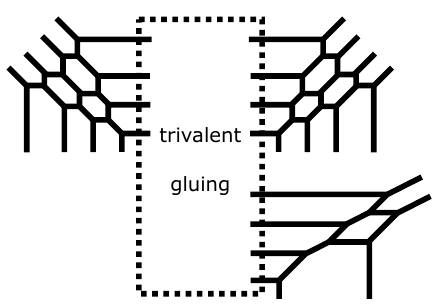
Figure 17. The web diagram for the minimal ( E 7 , E 7 ) conformal matter theory on a circle. The trivalent gluing is done so that the central SU(4) gauge node has the zero CS